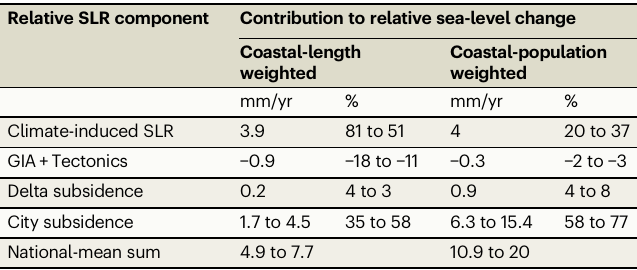
Table 1 | The contemporary contribution of the climate and geologic components to relative sea-level rise for length- weighted and population-weighted cases, respectively (for the year 2015)